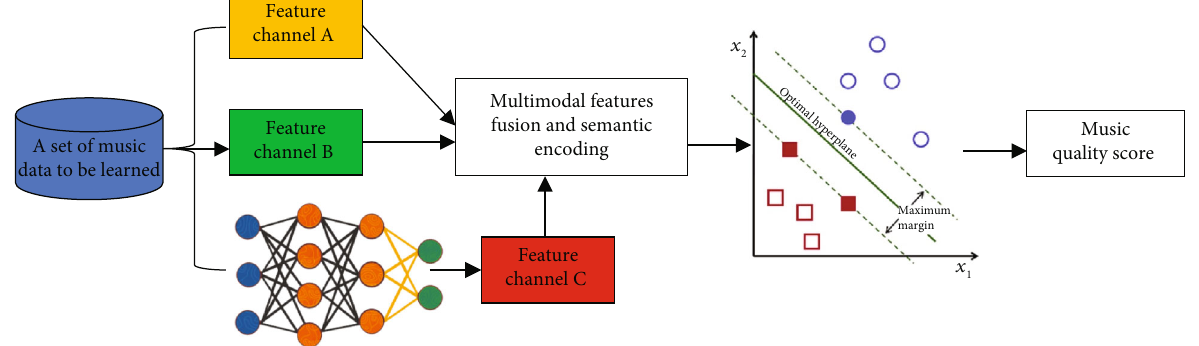
Figure 1: The fl owchart of our proposed music quality